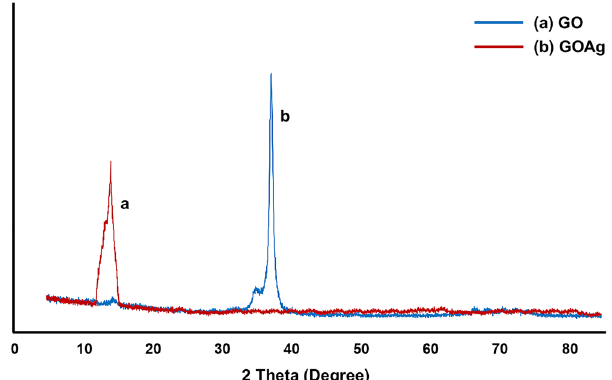
Figure 3. X-ray diffraction patterns of the GO-coated NiTi (GO) and GO/Ag-coated NiTi (GOAg)